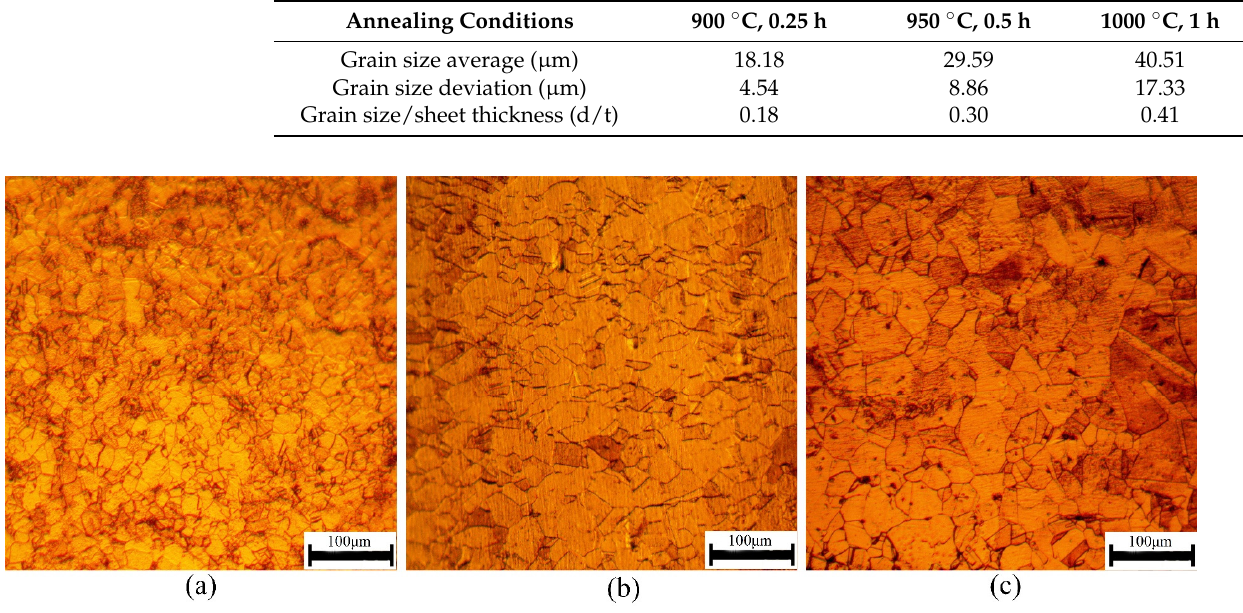
Figure 1. Microstructures of the 316LN stainless steel annealed at ( a ) 900 ◦ C, ( b ) 950 ◦ C and ( c ) 1000 ◦ C. Table 1. Heat-treatment parameters and the corresponding grain sizes. Annealing Conditions